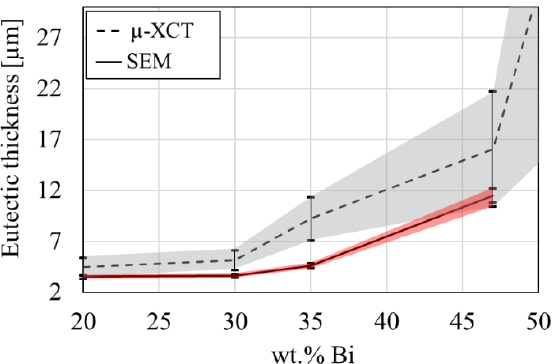
Figure 14. Comparison of the image analyzed eutectic thickness obtained from the µ -XCT data and SEM data as a function of alloy composition. Error bars indicate the standard deviation of eutectic thickness.